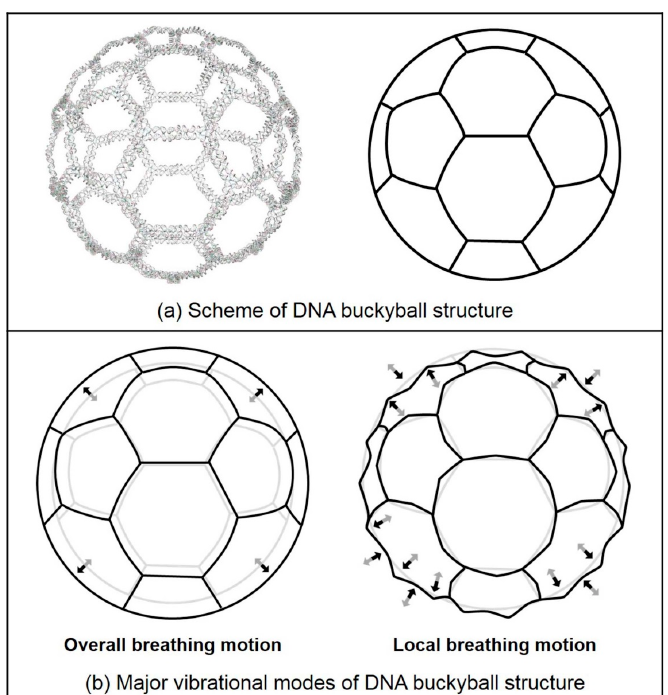
Figure 5. Schematics of the DNA buckyball structure and its major vibration modes. ( a ) The scheme of the DNA buckyball is represented as soccer ball. ( b ) Major vibrational modes of the DNA buckyball are overall breathing motion and local breathing motion. Overall breathing motion is the swelling of the entire buckyball structure, and local breathing motion forms a spiky shape. Its conformational change from initial to final structures is depicted in gray and black, respectively.